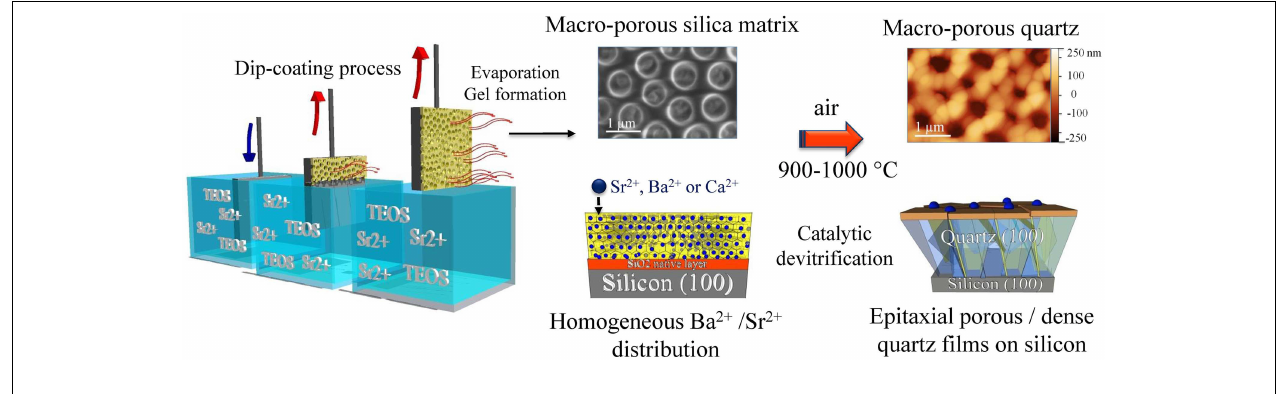
FIGURE 4 | Crystallization mechanism of nanostructured epitaxial α -quartz thin films on silicon substrate. Note that this growth mechanism is prepared by a dip-coating process. During the gelification and drying of films, strontium, barium or calcium ions were uniformly distributed within the amorphous silica matrix. After